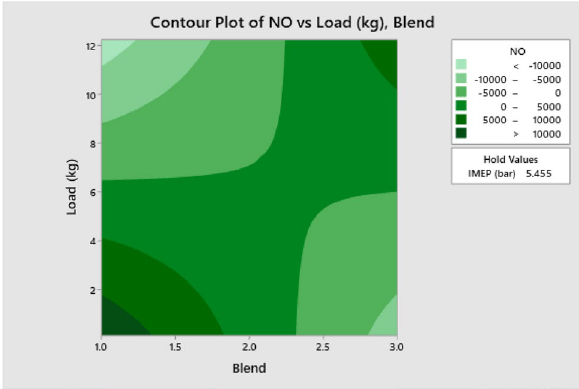
Fig. 30 Contour plot of CO